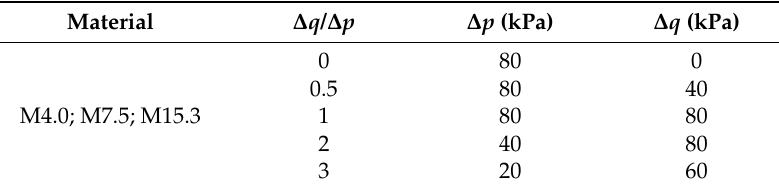
Table 3. Stress paths applied in the resilient test